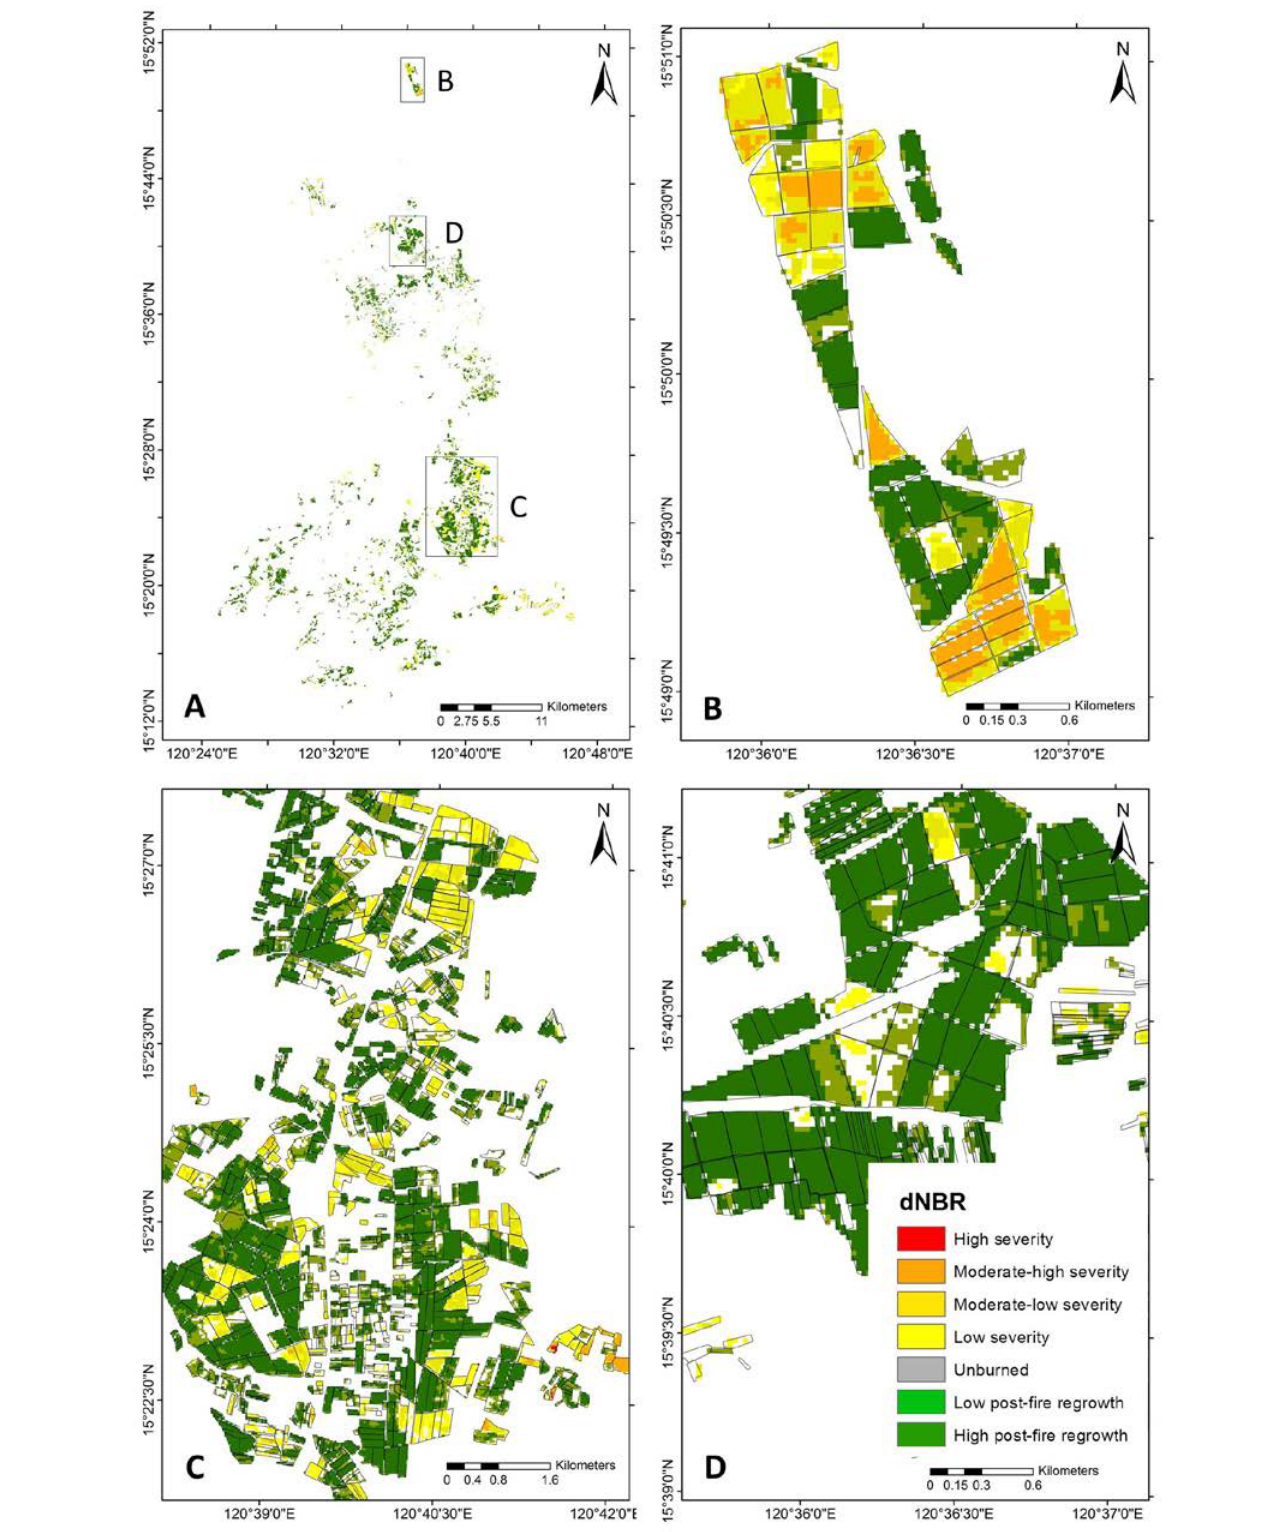
Figure 4. Burn Severity maps of Feb to May dNBR for (A) the entire Tarlac; zoomed in images of (B) San Manuel in the north, (C) La Paz and Concepcion in the south and (D) Paniqui and Ramos in the middle portion of Tarlac. The black outlines are the plot-level field-validated sugarcane boundaries by